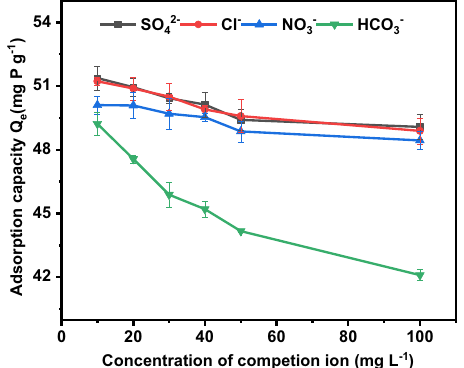
Fig. 4 Effect of other anions on the adsorption of phosphate. Experimental conditions: 50 h, 10 g (HIAO/225H)/L, 20 mg P/L, pH 6.0, room temperature of ∼ 30 °C; and experimental condition ( n = 3 ±standard deviation